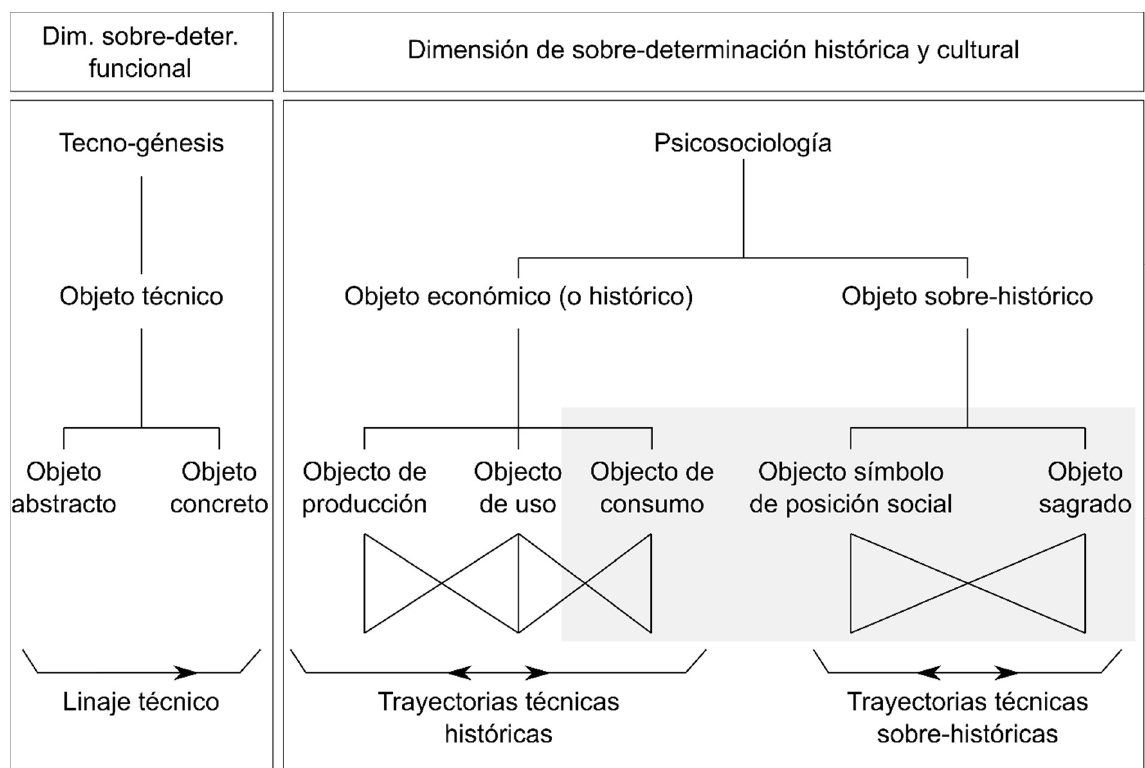
Figura 6. Dos perspectivas complementarias de los objetos de la prehistoria. La zona gris representa el solapamiento posible entre las dimensiones económica y